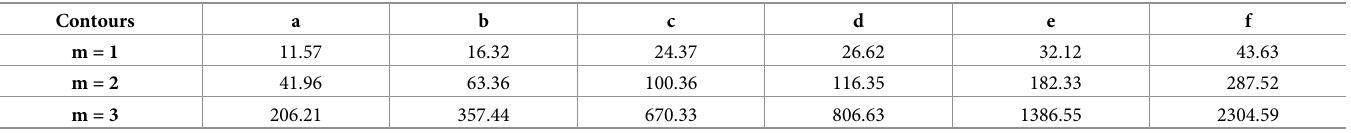
Table 2. The shape irregularities of different shaped tomatoes.